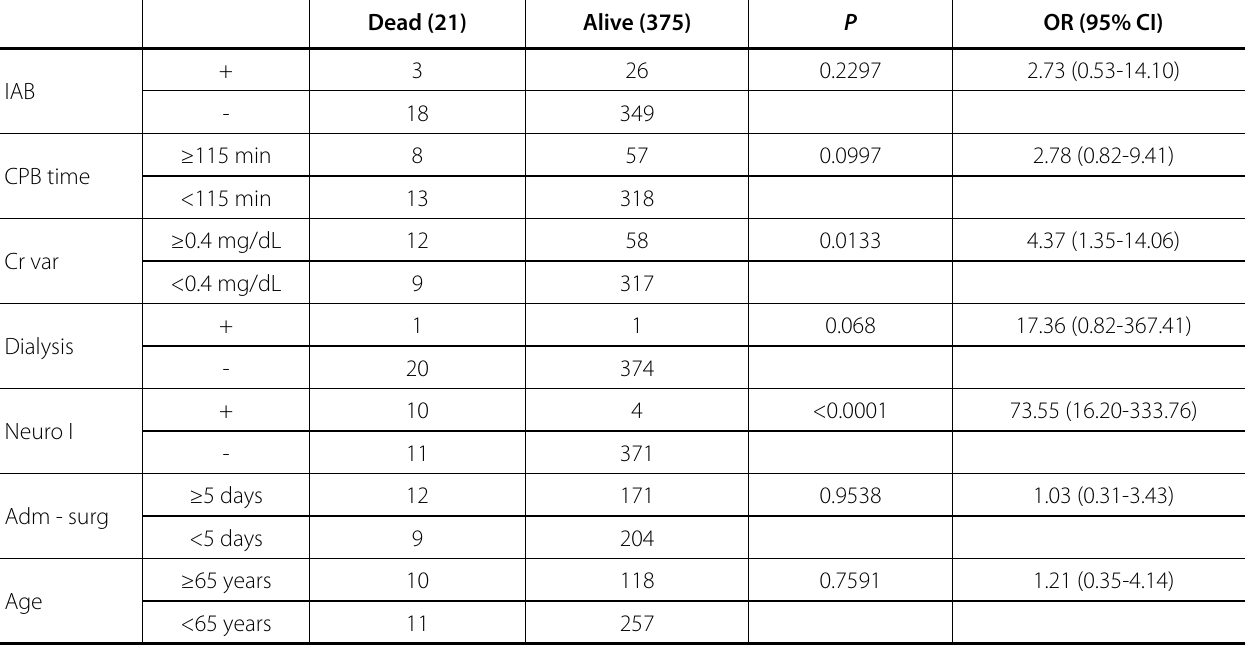
Table 2 . Mortality risk factors among ONCABG patients (n=396) with AC levels greater than or equal to 1 and less than 1.2 mg/dL